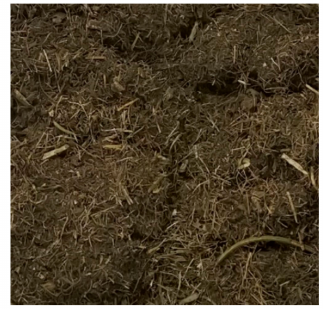
Figure 1. Stevia